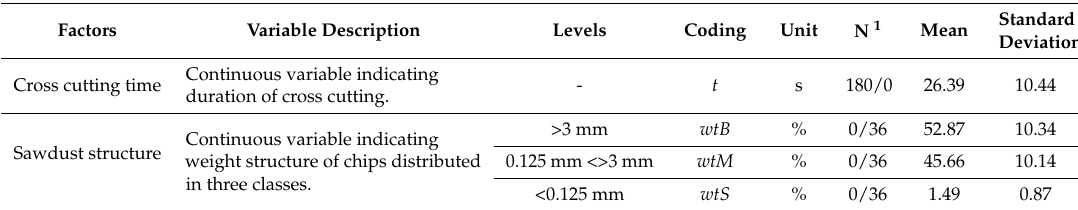
Standard Deviation